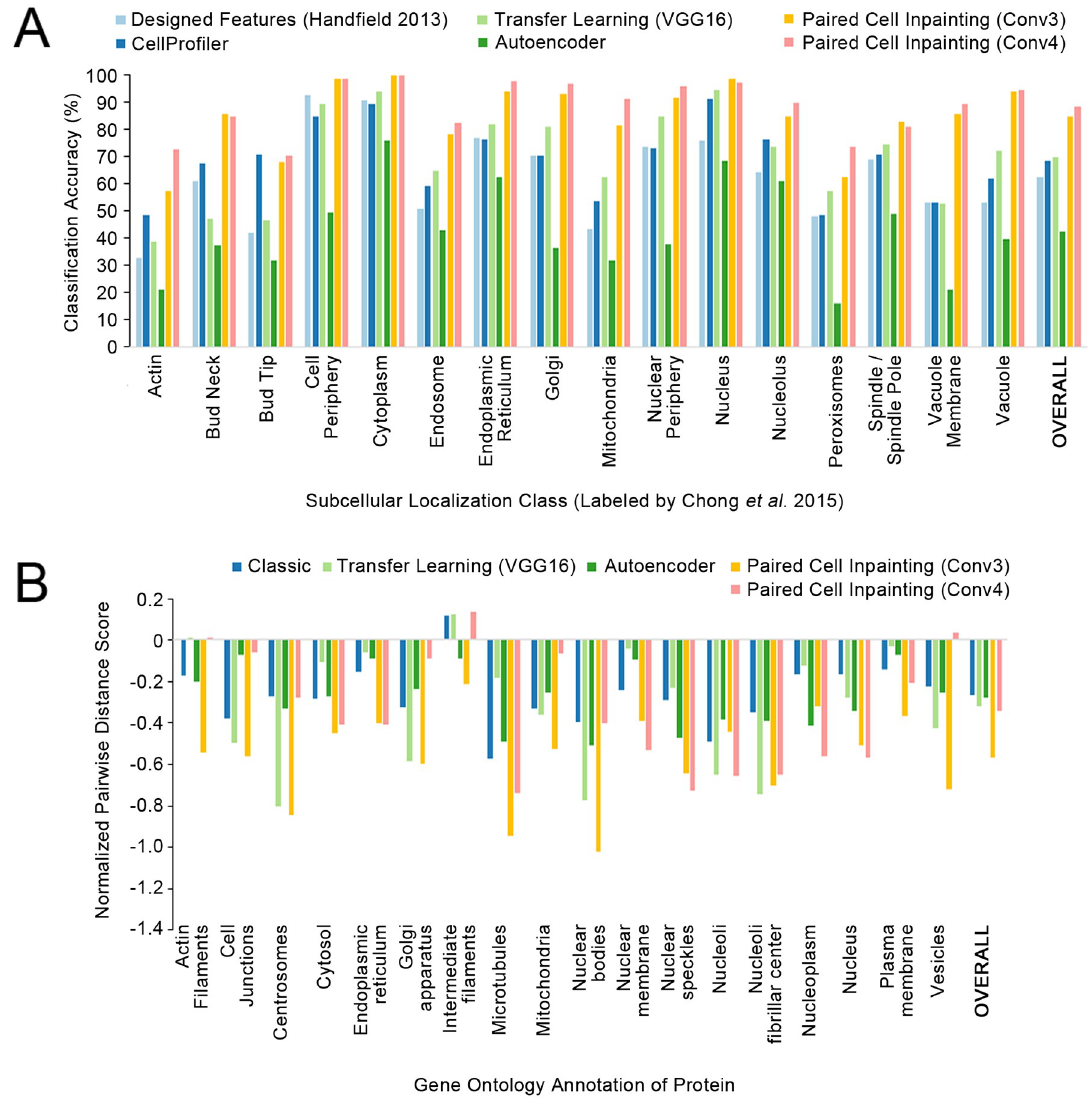
Fig 2. Quantitative comparisons of paired cell inpainting features with other unsupervised feature sets. (A) Overall and class-by- class performance benchmark for yeast single cell protein localization classes using unsupervised feature sets and a k NN classifier ( k = 11) on our test set. For all approaches extracting features from CNNs (Transfer Learning, Autoencoder, and Paired Cell Inpainting), we extract representations by maximum pooling across spatial dimensions, and report the top-performing layer. We report the overall accuracy as the balanced accuracy of all classes. (B) The normalized pairwise distance between cells with the same localization terms according to gene ontology labels, for proteins in the Human Protein Atlas. A more negative score indicates that cells are closer in the feature set compared to a random